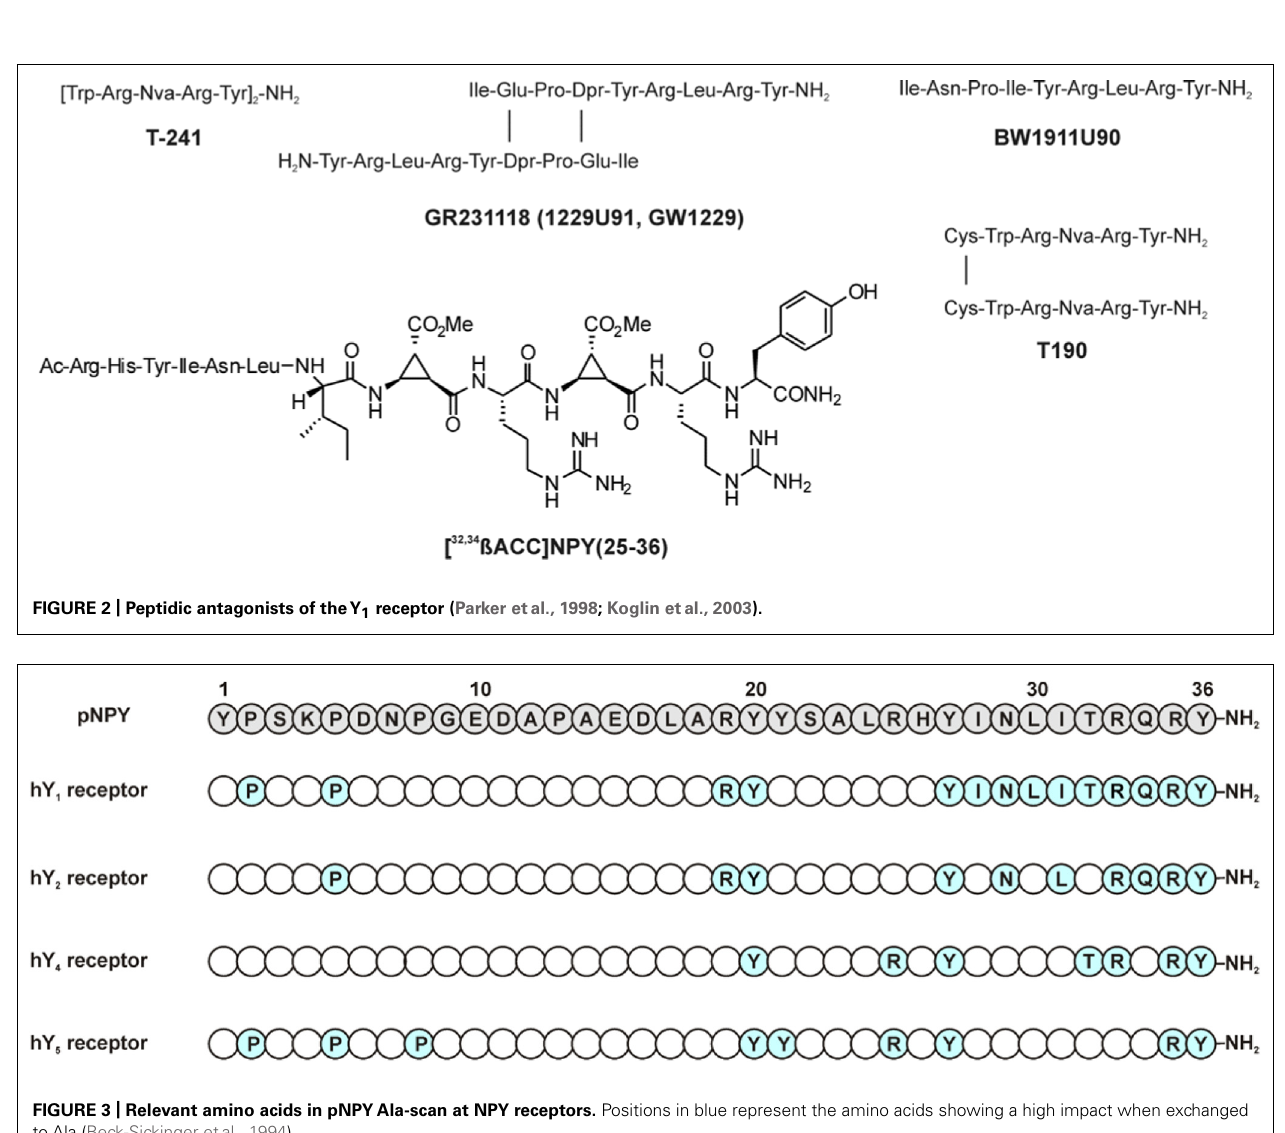
40-fold lower affinity. A more dramatic effect could be observed fold),Gln 34 (150-fold),Arg 35 (75000-fold),andTyr 36 (17500-fold; Figure 3 ; Cabrele and Beck-Sickinger, 2000; Eckard et al., 2001). Interestingly, the introduction of a Pro residue at position 34 is not tolerated at the Y 2 receptor, which is in contrast to the effect observed on the other Y receptor subtypes (Beck-Sickinger et al., 1994; Keire et al., 2000b; Eckard et al., 2001). Although Tyr 36 may not be substituted by Ala, the introduction of Hty (homotyro- sine) or p-substituted Phe in PYY(3–36) is well tolerated at the Y 2 receptor, but almost completely abolishes binding of the mod- ified NPY analogs at Y 1 or Y 4 receptors (Pedersen et al., 2009). Taken together, these data underline the importance of the C- terminal part of the peptide ligand for high-affinity binding to the Y 2 receptor, despite the fact that the binding pocket for NPY at the Y 2 receptor seems to be less narrow than the ones of Y 1 or Y 4